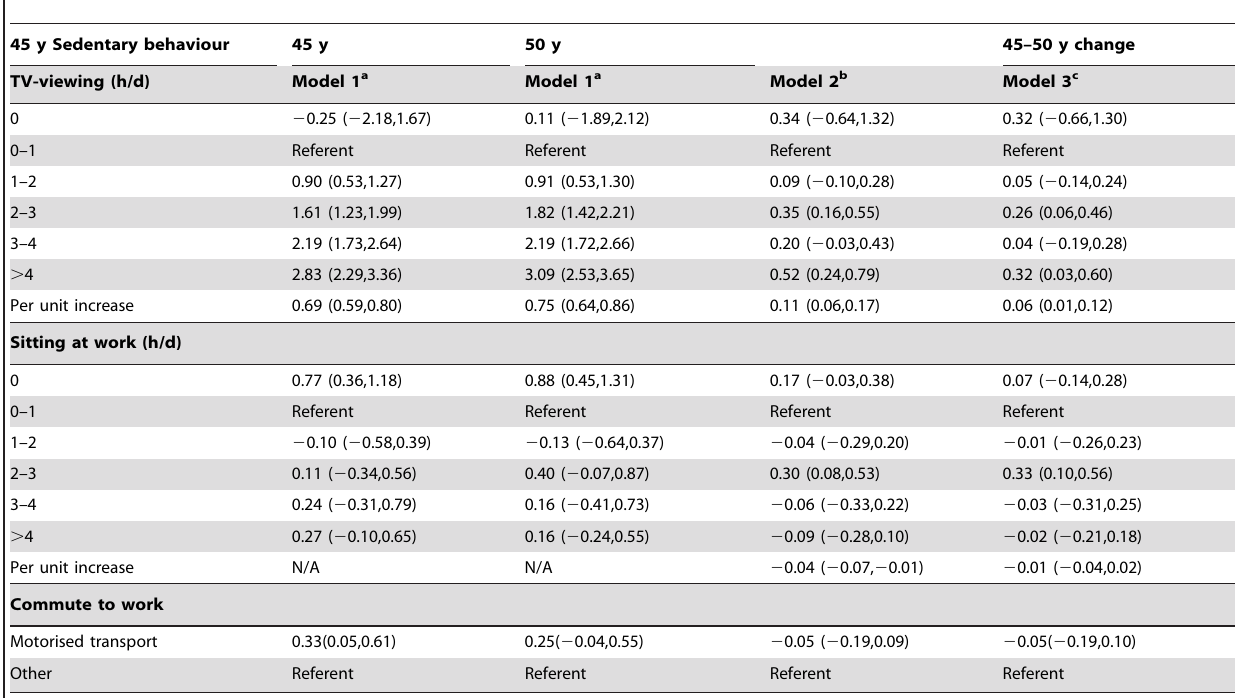
CI: confidence interval. *Results based on imputed data. a Model 1 adjusted for gender. b Model 2 adjusted for gender and 45 y BMI.